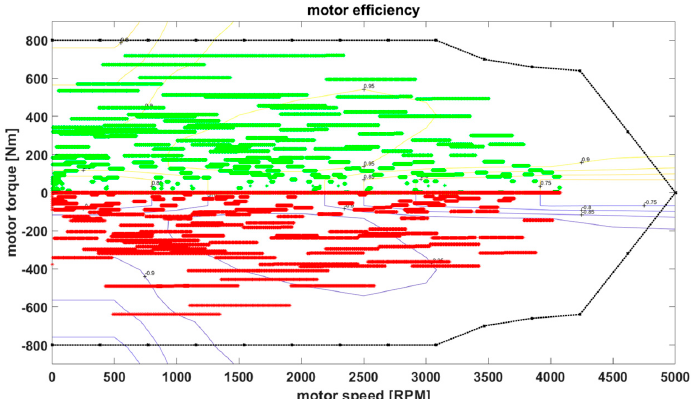
Figure 8. Electric-motor operating points of EV.